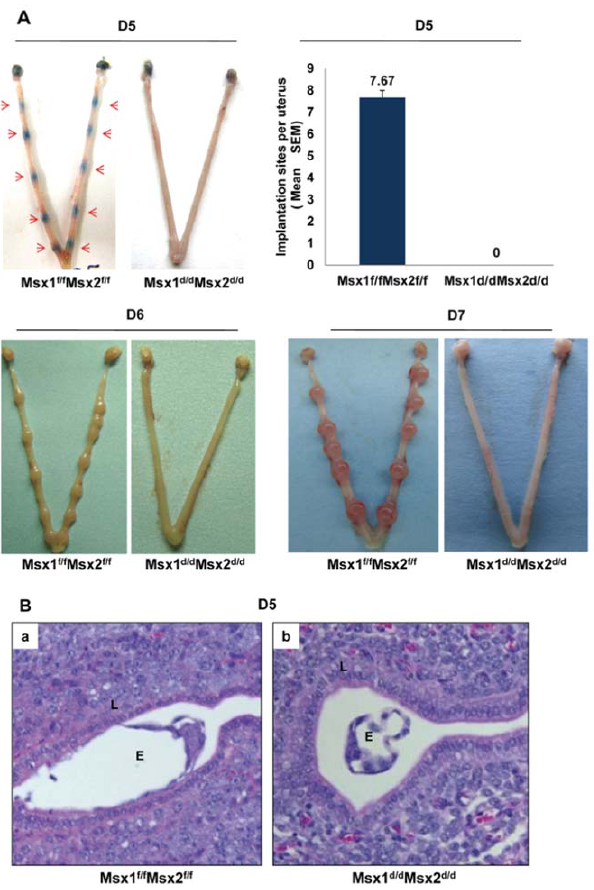
Figure 2. Lack of uterine Msx 1 and Msx 2 causes implantation failure. A. Embryo implantation sites were examined in Msx1 f/f Msx2 f/f and Msx1 d/d Msx2 d/d mice by the vascular permeability assay, which can be scored as distinct blue bands (red arrows) following an injection of Chicago blue dye on day 5 of pregnancy (D5, n=6) or direct eye- visualization of implanted embryo on day 6 (D6, n=4) and on day 7 (D7, n=4) of pregnancy. The graph represents the quantification of implantation sites in Msx1 f/f Msx2 f/f and Msx1 d/d Msx2 d/d mice on day 5 of pregnancy. B. Failure of embryo attachment in Msx1 d/d Msx2 d/d uteri. Histological analysis of uterine sections obtained from Msx1 f/f Msx2 f/f (a) and Msx1 d/d Msx2 d/d (b) mice on day 5 (n=3) of pregnancy by Hematoxylin and Eosin staining. Note the intimate contact between embryo and luminal epithelium in Msx 1 f/f Msx 2 f/f mice and the free floating embryo in the uterine lumen of Msx 1 d/d Msx 2 d/d mice. L and E indicate luminal epithelium and embryo respectively.